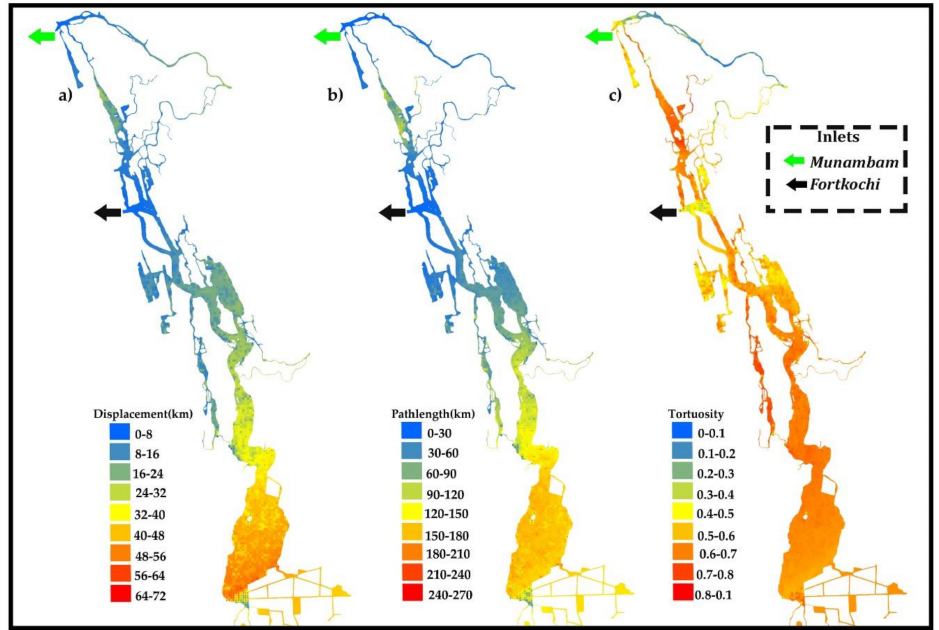
Figure 13. Displacement ( a ), path length ( b ) and tortuosity ( c ) of the CE during the summer